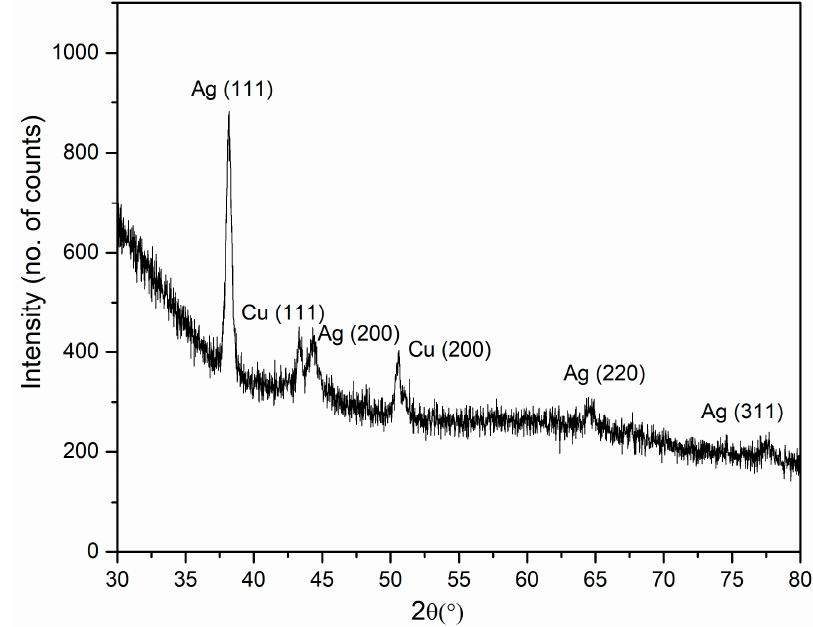
Figure 2. XRD spectrum of copper-silver bimetallic nanostructures.